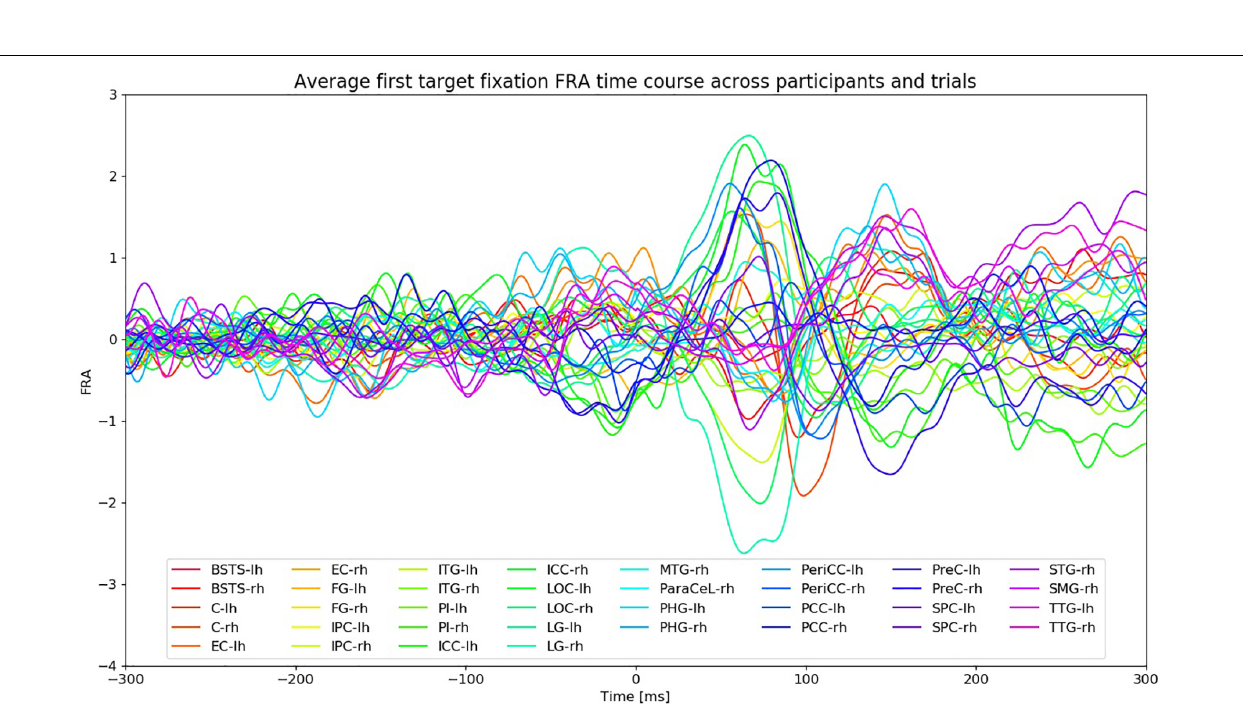
Frontiers in Neuroscience |